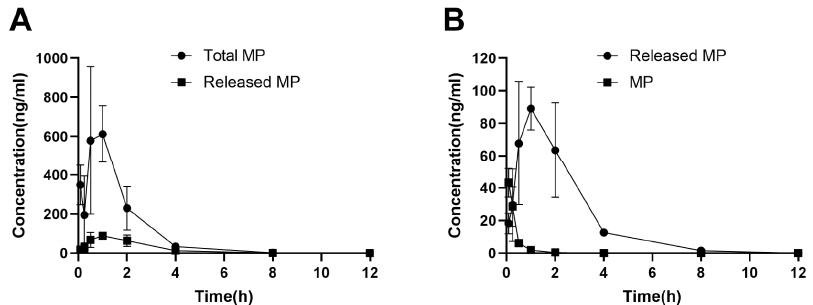
Figure 8. ( A ) Total and released MP levels in the kidneys after administration of MPS–LZM; ( B ) MP levels in the kidneys after administration of MPS–LZM and MP. Data represent mean ± SD ( n = 6).